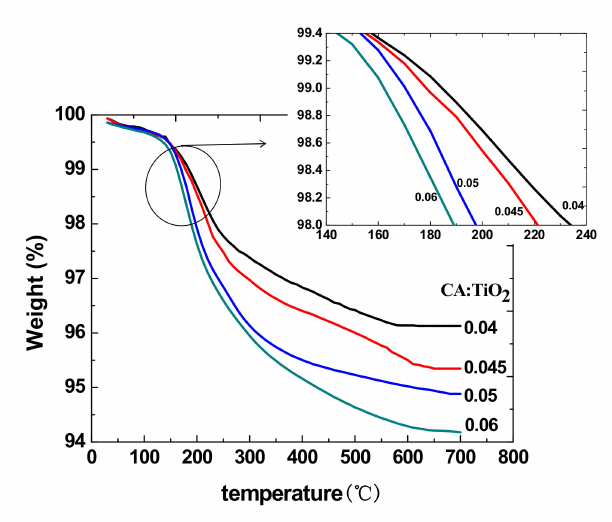
Figure 7. DTA-TG characterization of CA / TiO 2 hybrid sheets.